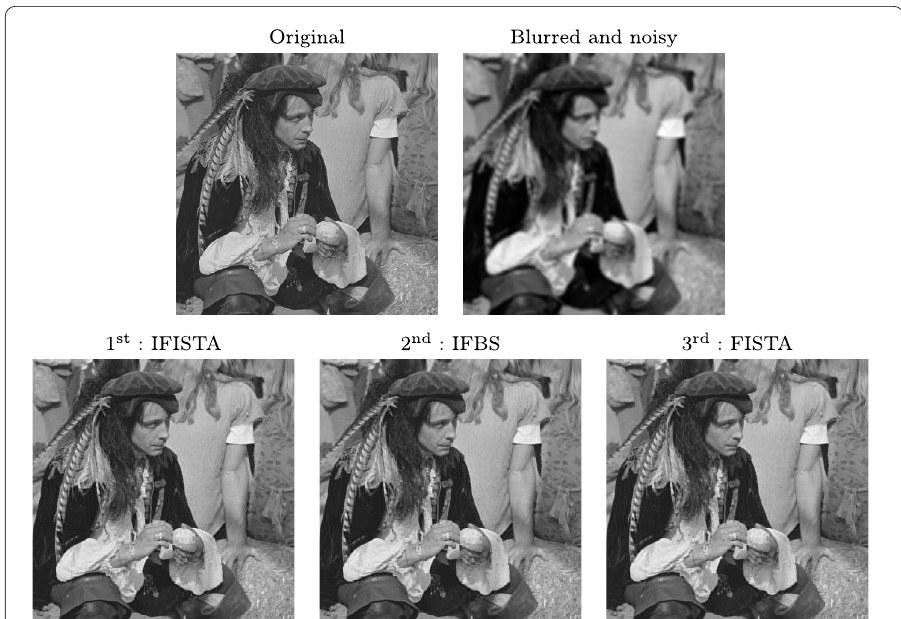
Figure 7 Top three fast processing with high performance for deblurring of Pirate